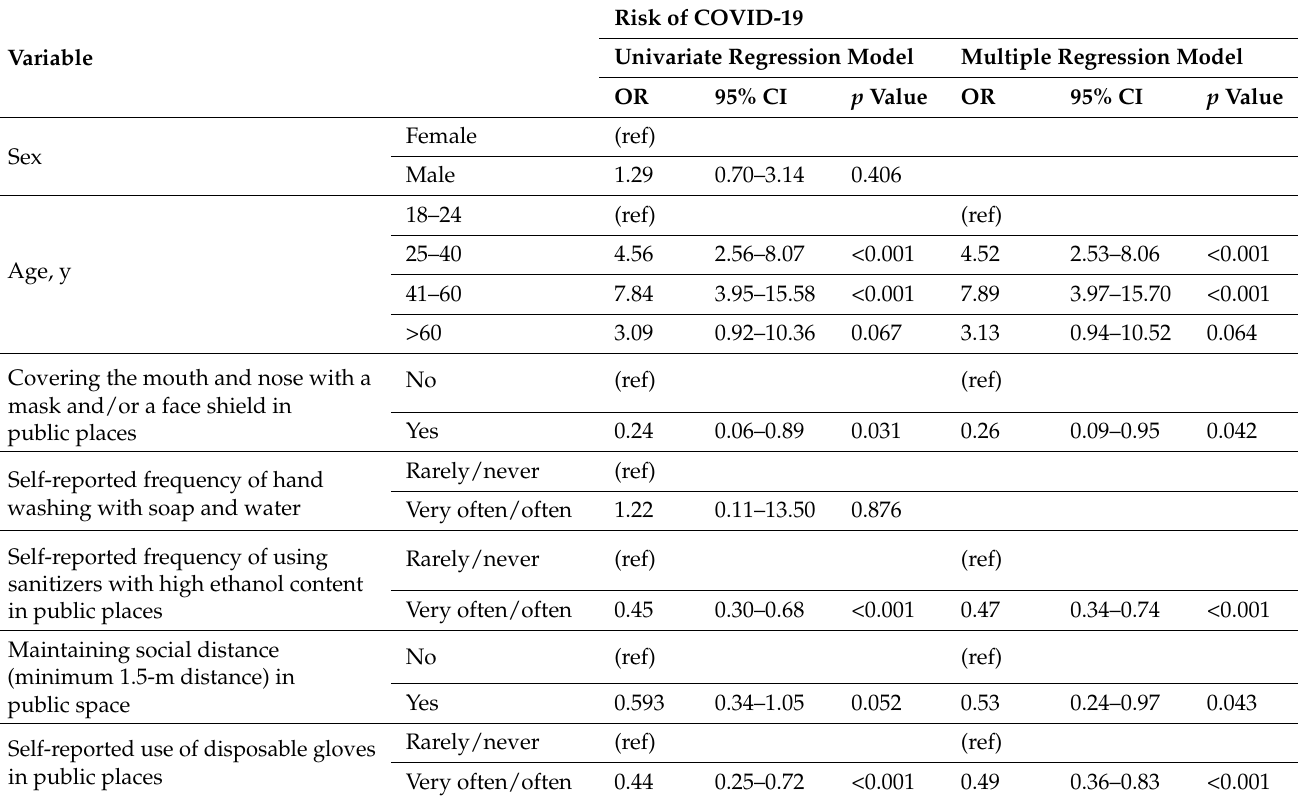
Table 5. Univariate and multiple logistic regression model of the association between compliance with sanitary measures and the risk of COVID-19 among